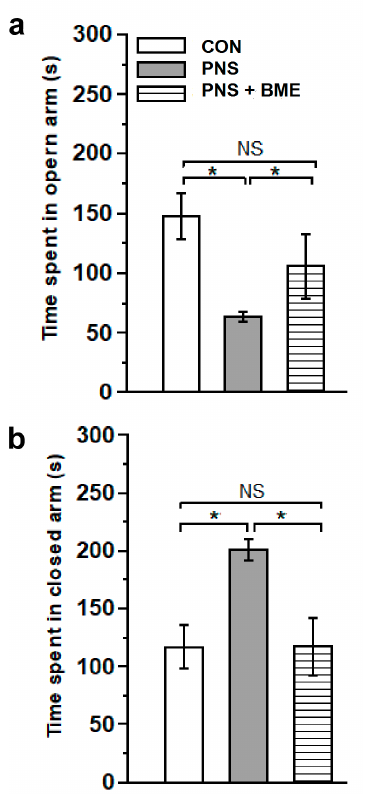
Figure 1. Exposure to BME treatment and resilience effect on the prenatal stress (PNS)-induced anxiety-like behaviors in the offspring. Behavioral profile in the elevated plus maze (EPM). ( a ) Total time spent in the closed arm; ( b ) Total time spent in the open arm. The anxiety induced by the gestational stress was significantly reduced by the maternal exposure to the BME treatment. Data are expressed as mean ± SEM (control n = 7, PNS n = 6, PNS + BME n = 6). One-way ANOVA followed by Bonferroni post hoc test (for all pairwise multiple comparisons, statistical significance is indicated by * p < 0.05; NS—Not significant).